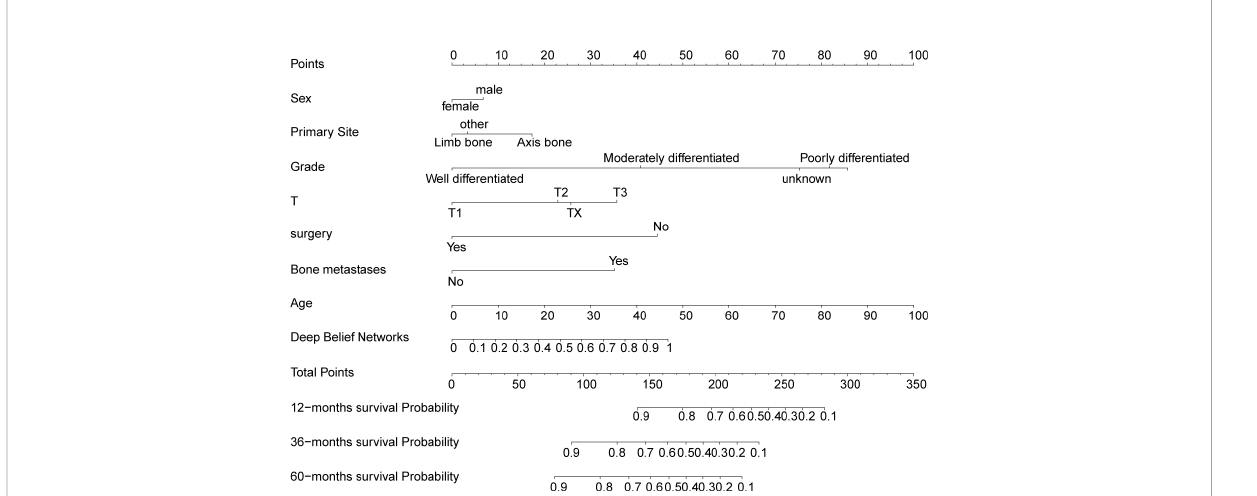
FIGURE 4 Nomogram for predicting overall survival for 1-, 3-, and 5-years in OS patients. Each variable value for the individuals was determined according to the top Points scale, and then the points for each variable were added. Finally, a personalized survival probability was obtained according to the bottom Total Points